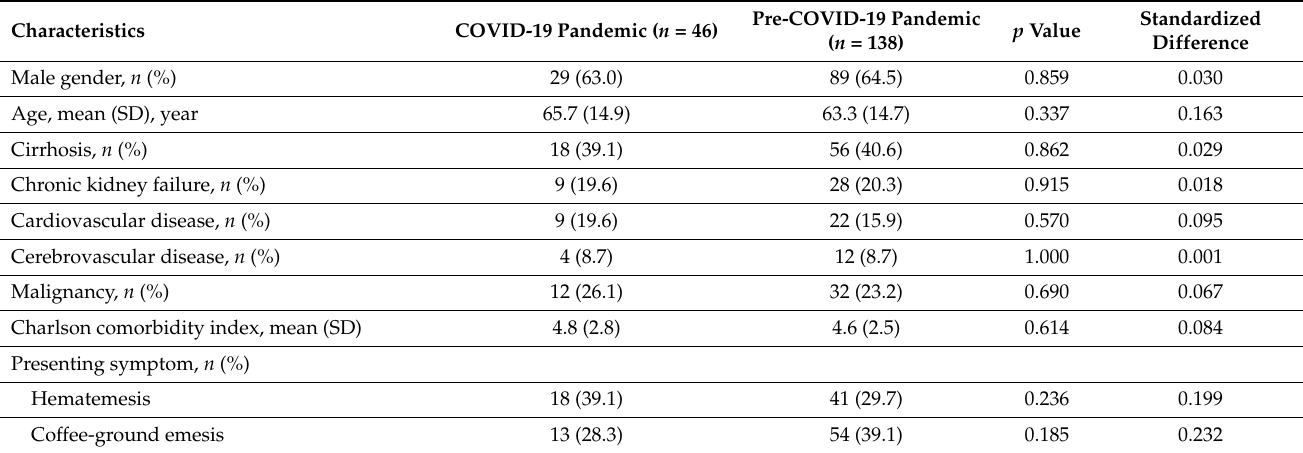
Table 2. Baseline characteristics of the matched